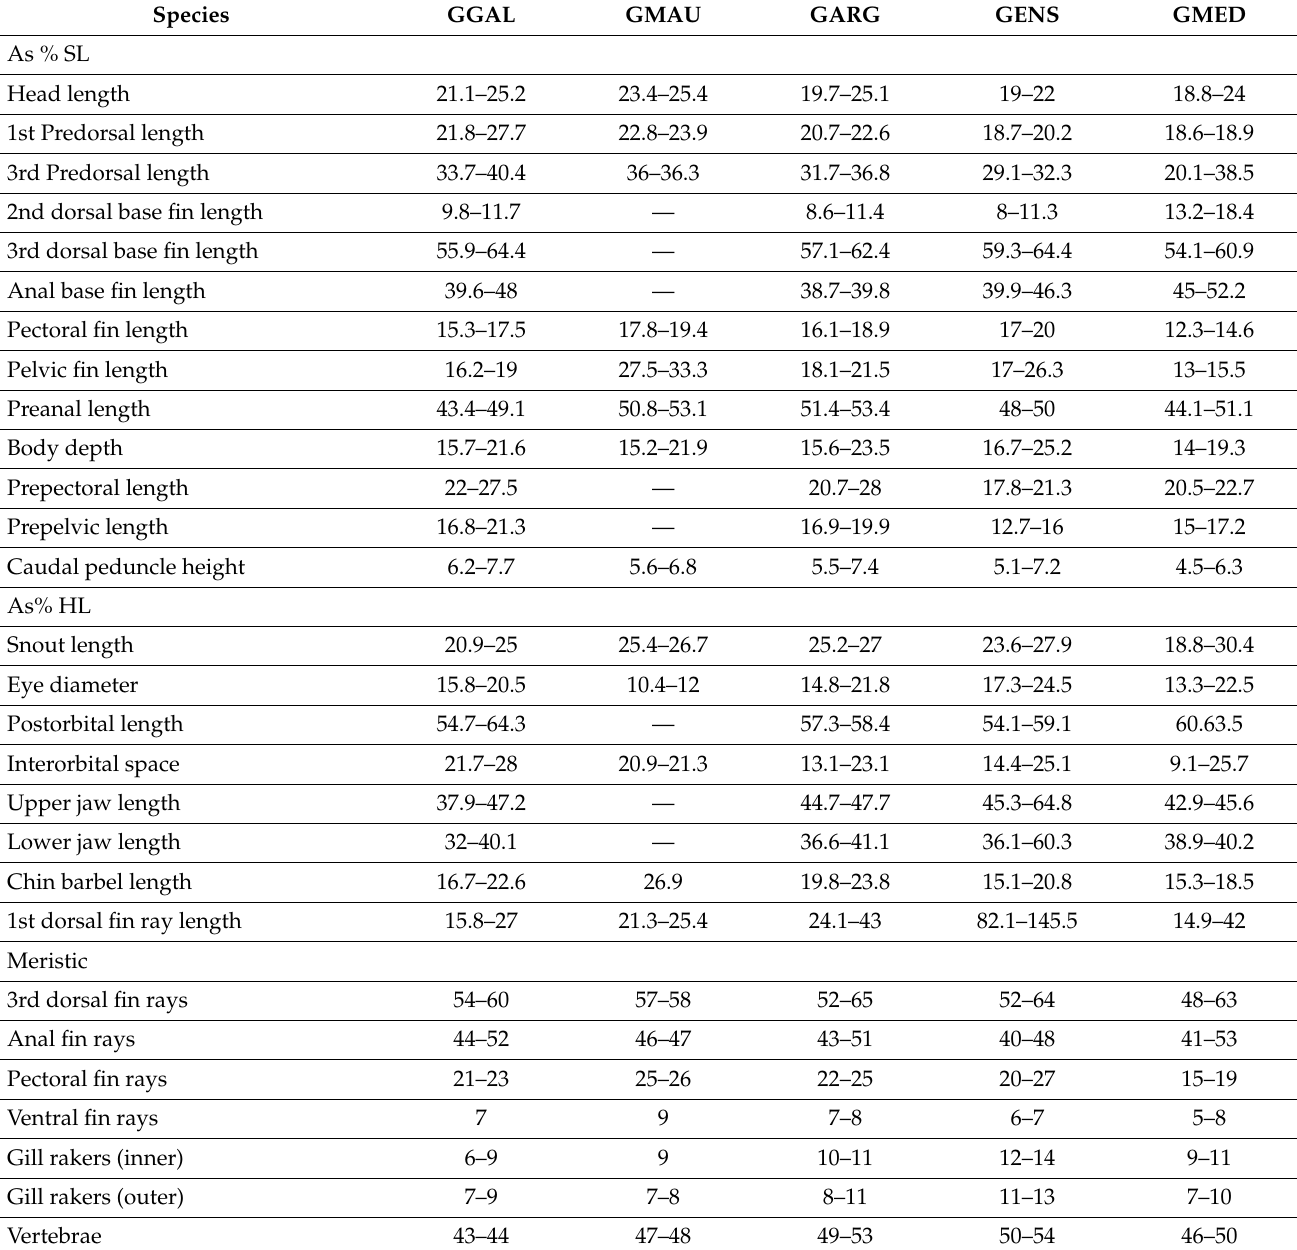
Table 2. Comparison of morphological data between Gaidropsarus gallaeciae sp. nov and 12 valid species of the genus. Abbreviations are as follow: Gaidropsarus gallaecia sp. nov. (GGAL), G.